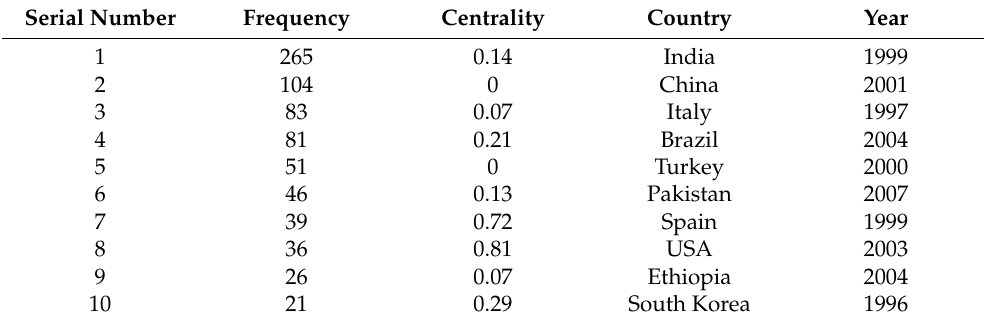
Table 2. Top 10 productive countries in tannery wastewater research. This list summarizes the ten most prolific countries in the field of tannery wastewater research from 1991 to 2022. India is on top of the list, followed by